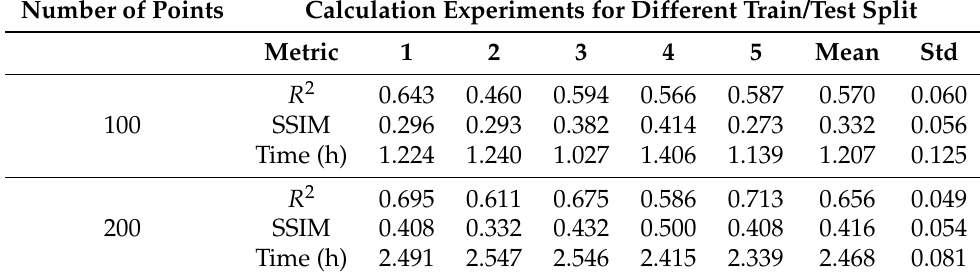
Table A1. Application of the genetic algorithm.